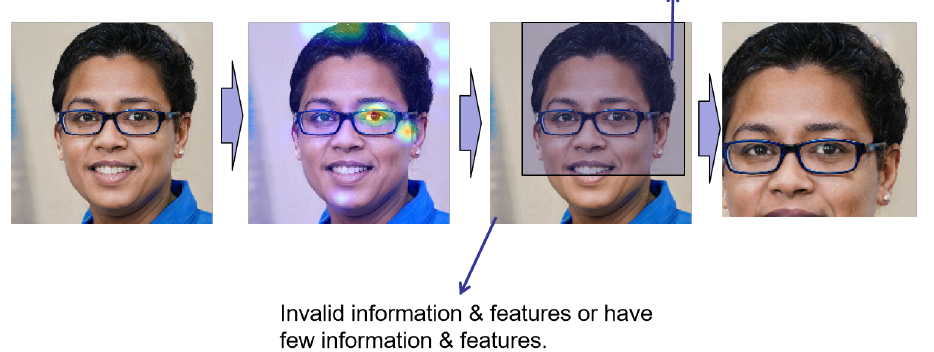
Figure 6. GAN network low-resolution to high-resolution feature mapping. In this figure, the fake face is from the open source StyleGAN2